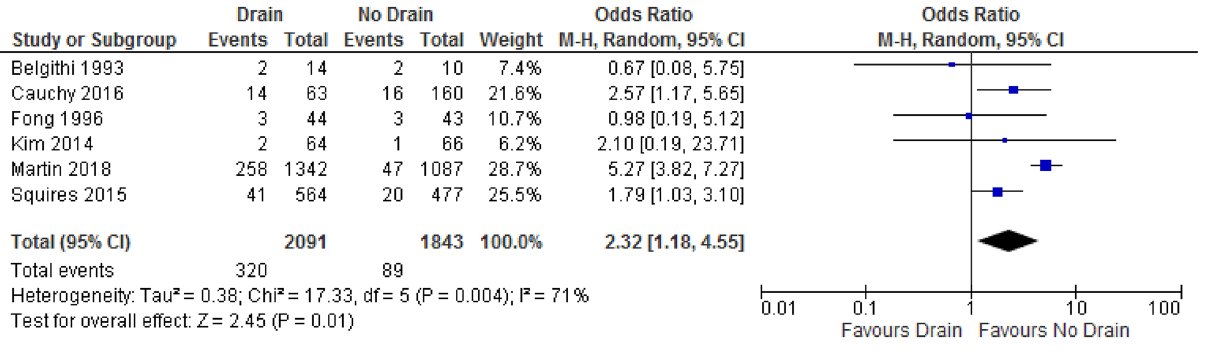
Figure 2. Forest plot of postoperative bile